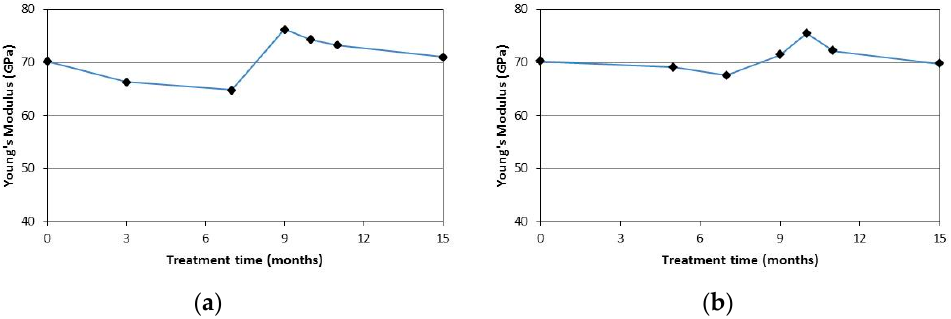
Figure 15. Young’s modulus vs. treatment time for SR-series ( a ) NaCl solution; ( b ) deionized water. Materials 2016 , 9 , 603